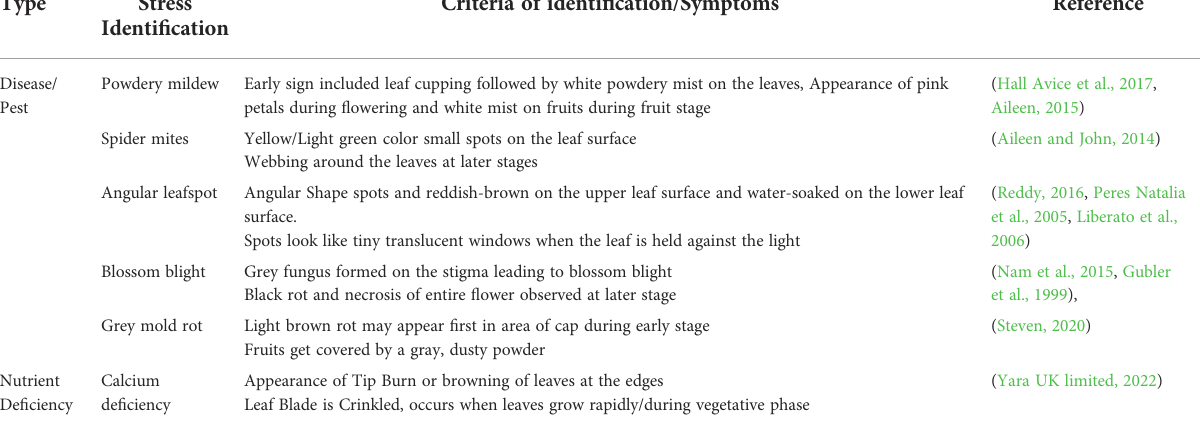
TABLE 1 Criteria for disease/pest labeling for each disease/pest.